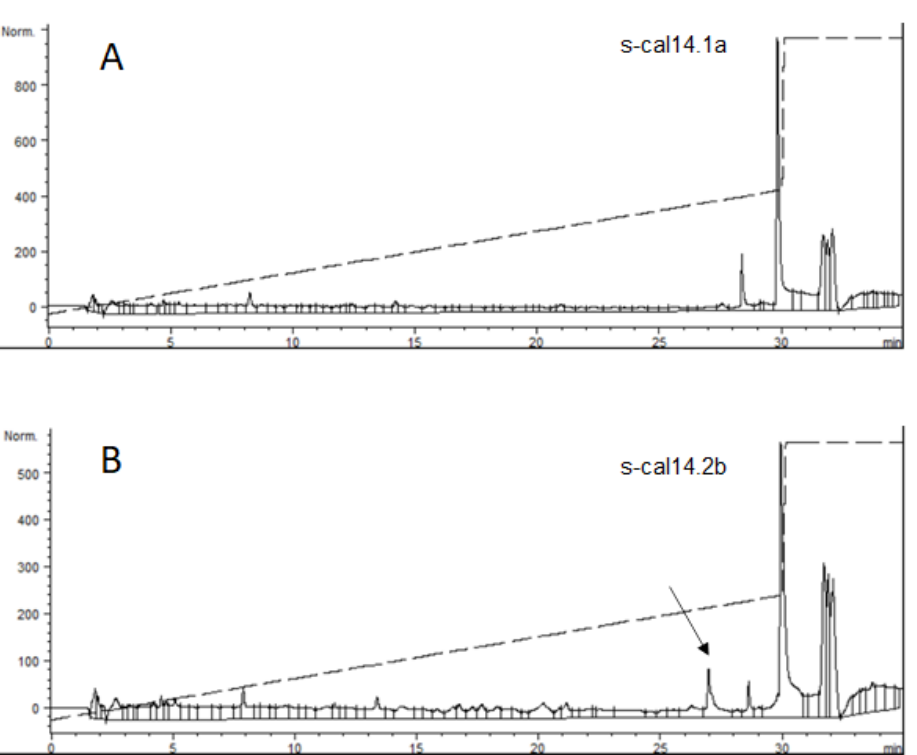
Figure 2. HPLC normalized chromatograms to detect insulin after ( A ) s-cal14.1a and ( B ) s-cal14.2b stimuli in NIT cells line (10 ng/mL for both peptides). The arrow indicated insulin retention time at 27 min (Rt 27), responsive to s-cal14.2b compare with the related synthetic peptide s-cal14.1a without insulin secretion effect.